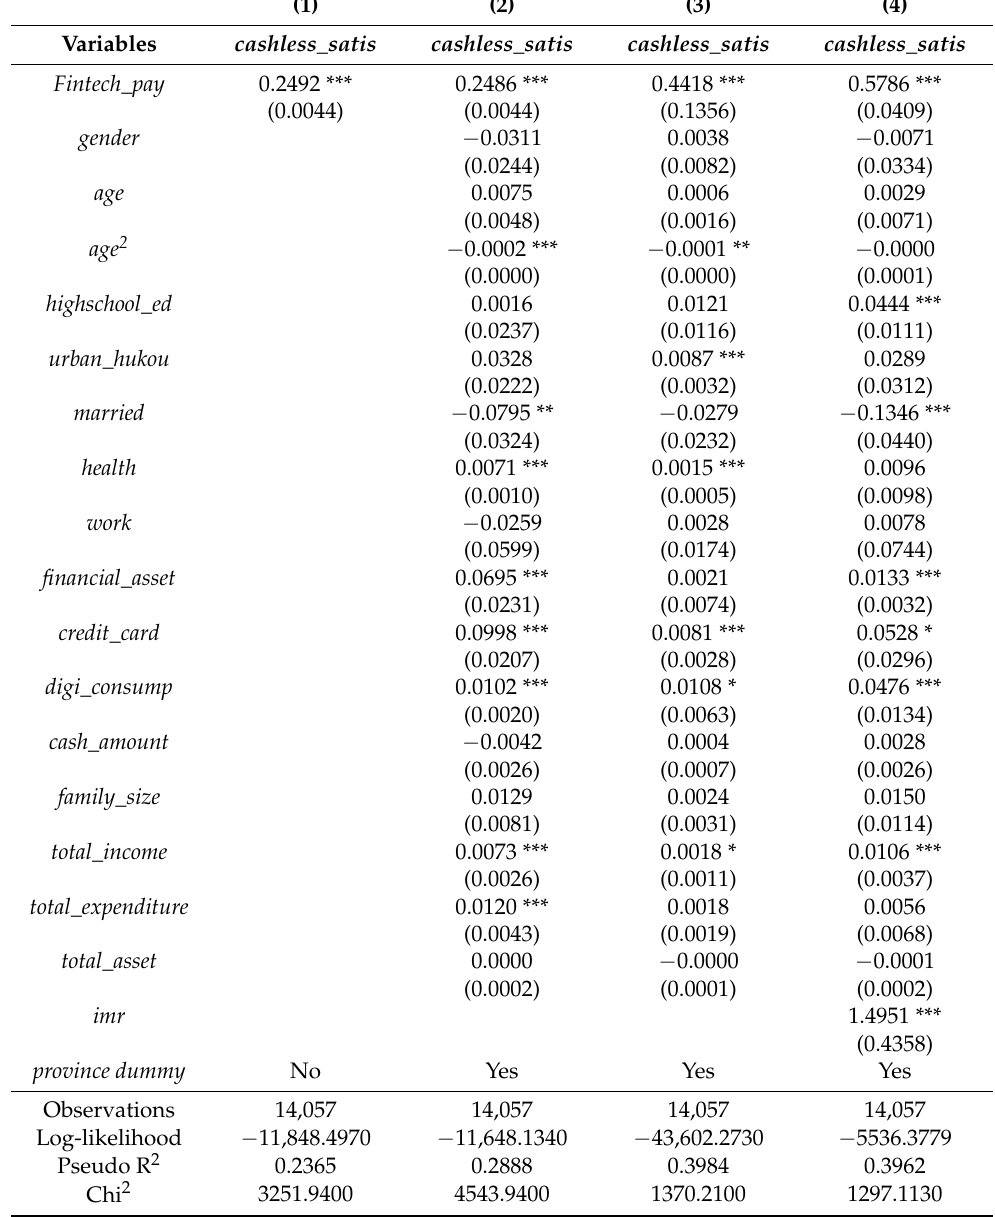
Table 3. Benchmark analyses and endogeneity correction (IV and Heckman’s two step